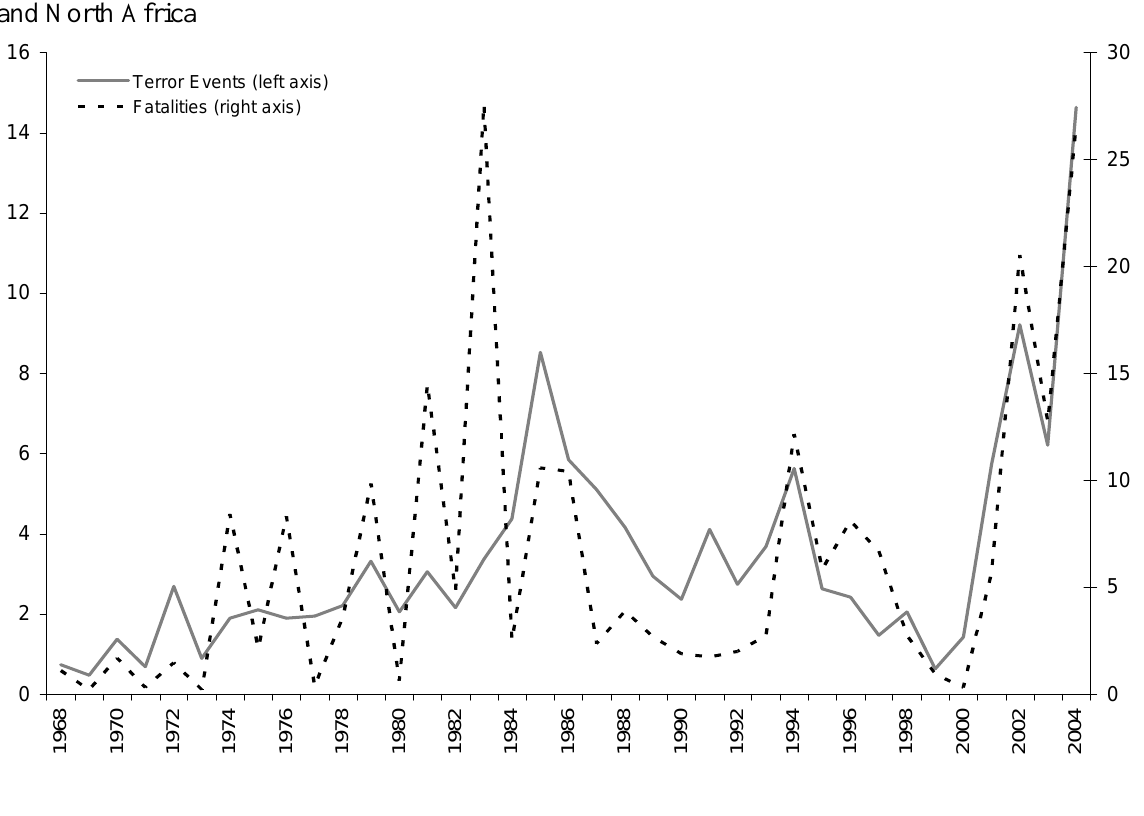
Average Number (per Country) of International Terrorist Events and Fatalities in the Middle East and North